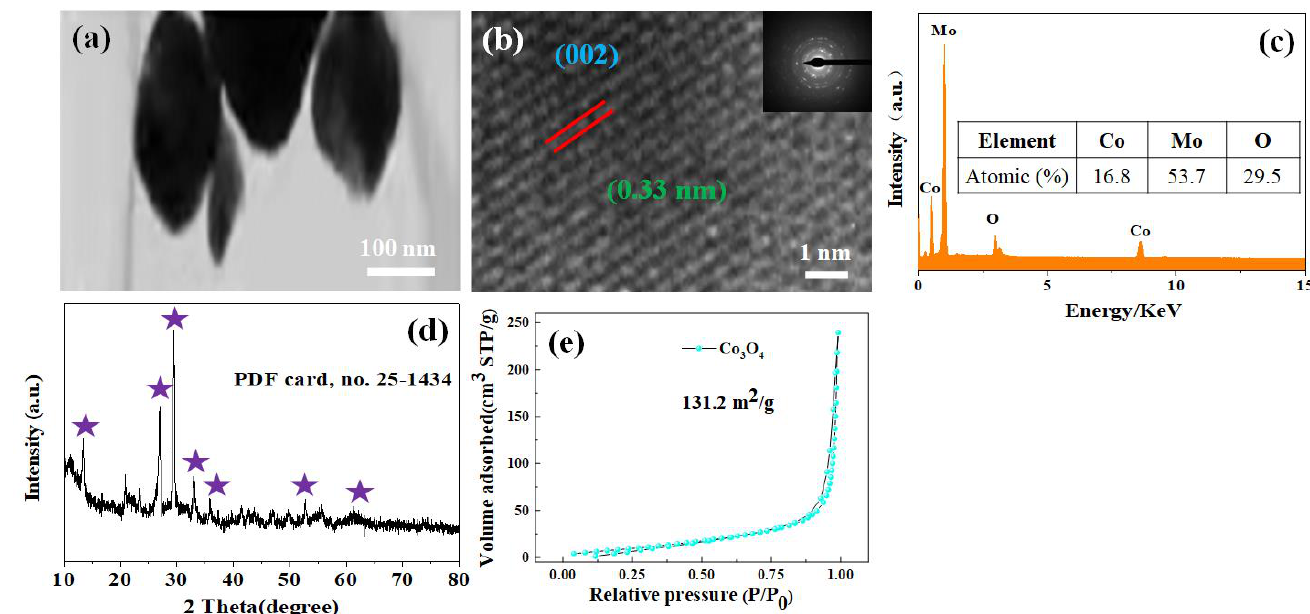
Figure 2. ( a ) TEM image of the hybrid CoMoO 4 pie nanoparticles. ( b ) HRTEM image of the as-pre- Figure 2. ( a ) CV curves of CoMoO 4 nanoparticles at different scan rates. ( b ) Charge–discharge pared CoMoO 4 nanoparticles and the inset is the corresponding SAED pattern. ( c ) The EDS spec- curves of CoMoO 4 nanoparticles at different current densities. ( c ) Specific capacitance of CoMoO 4 trum of CoMoO 4 nanoparticles. ( d ) XRD pattern of CoMoO 4 nanoparticles. ( e ) Nitrogen adsorption – nanoparticles at varied current densities. ( d ) The cycling performance of pie-shaped CoMoO 4 at the desorption isothermal curve. current density of 15 A/g. ( e ) Nyquist plot of CoMoO 4 nanoparticles. ( f ) Rate and cycle stability tests under different current